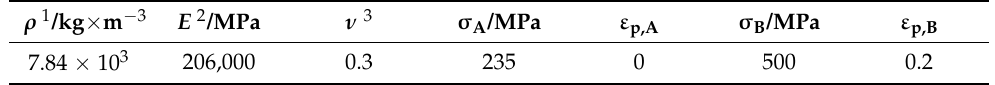
Figure 4. Stress–strain curve of the material. OA and AB represent the elastic and plastic stages, respectively, σ A and σ B represent the stress at points A and B, respectively, σ A is the yield stress, and 𝜀 𝜀 (cid:2926),(cid:2885) and (cid:2926),(cid:2886) represent the plastic strain at the two points.